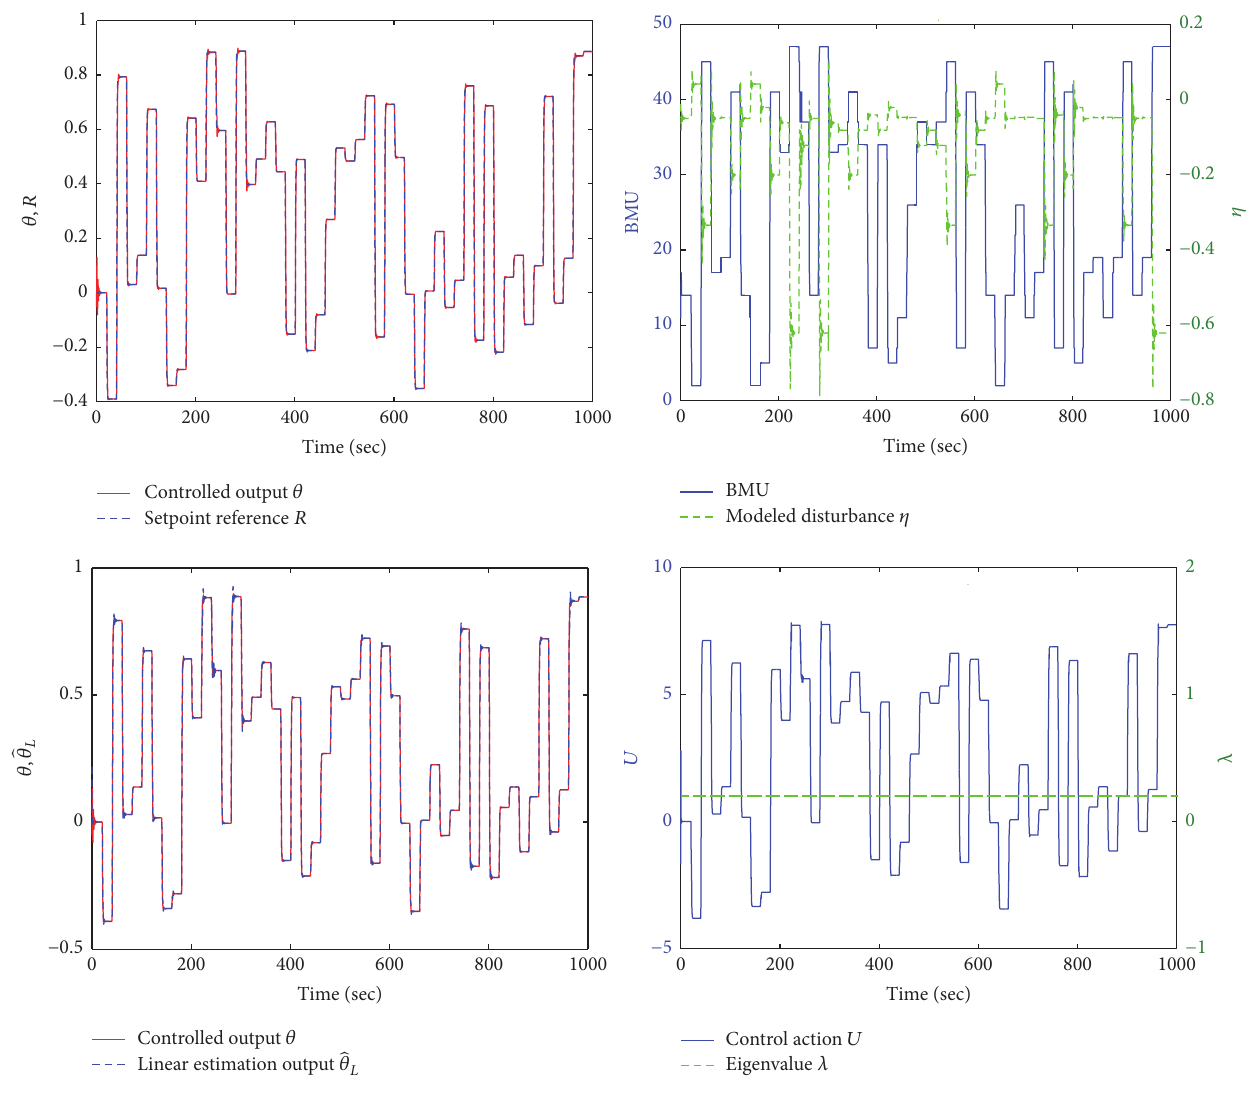
Figure 7: Results for 𝜆 prefilter = 0.7 and 𝜆 = 0.2